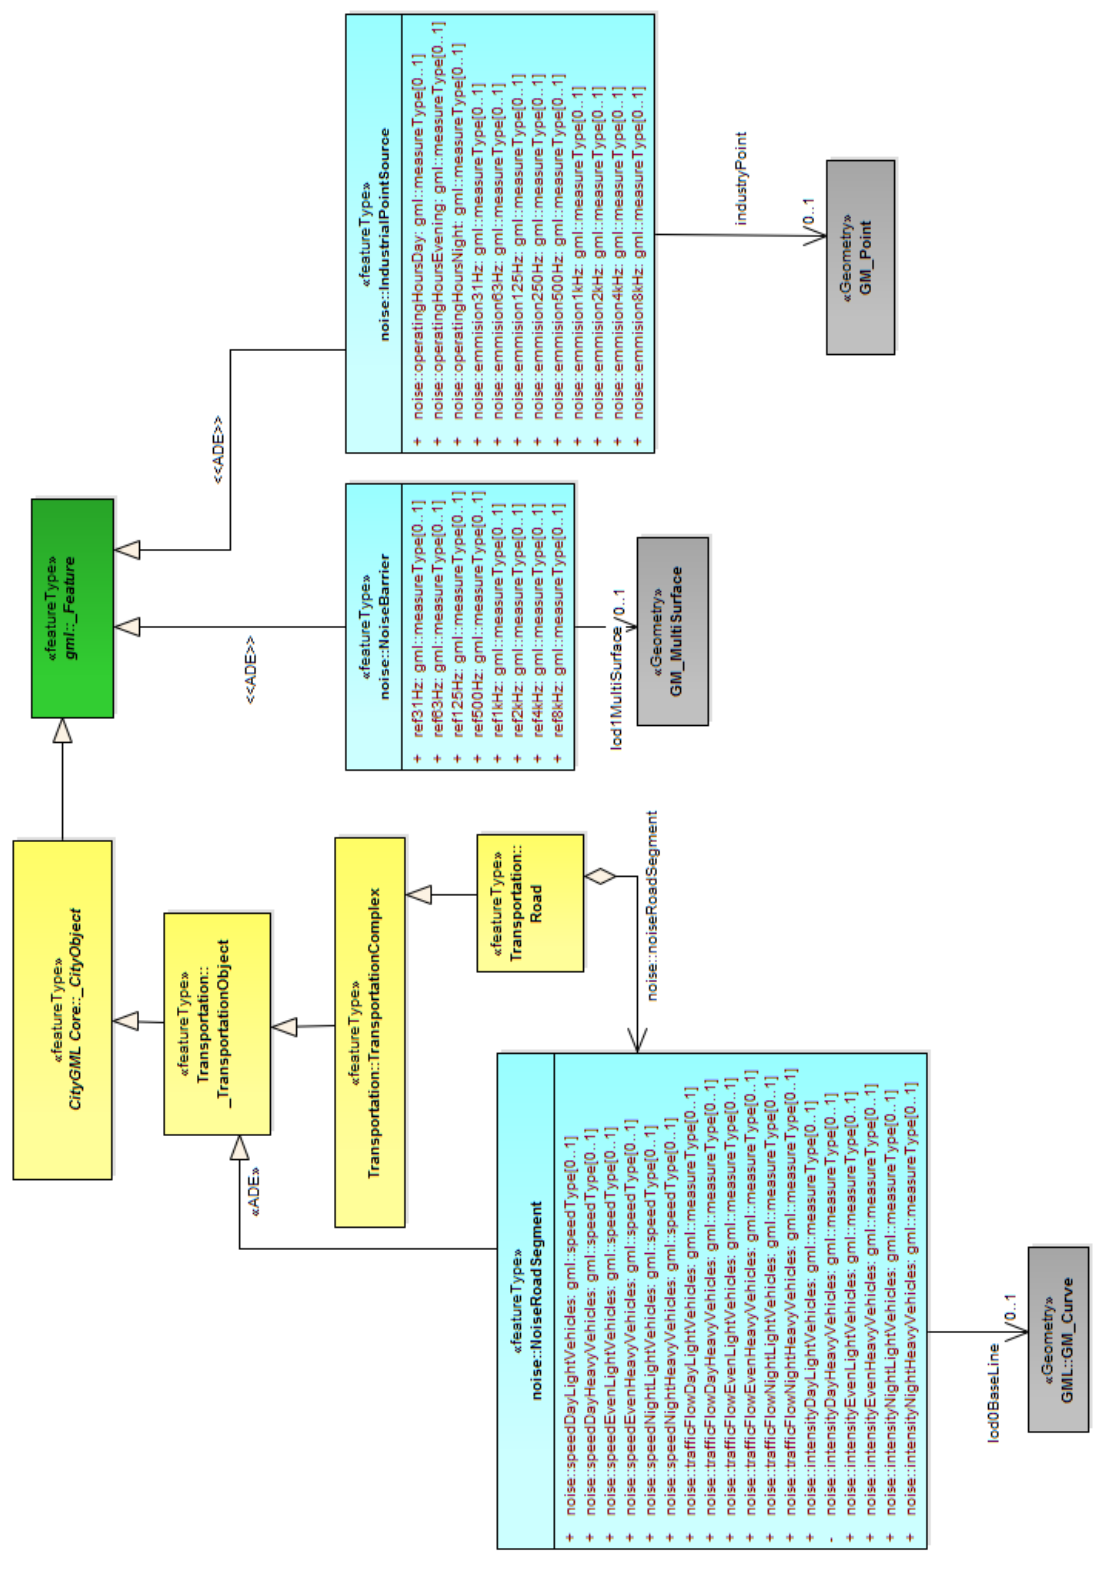
Figure 10: Extended CityGML Noise ADE UML for road and industrial noise (light yellow=CityGML Transportation module, light blue=Extended CityGML Noise ADE)(We removed the existing noise attributes for easy